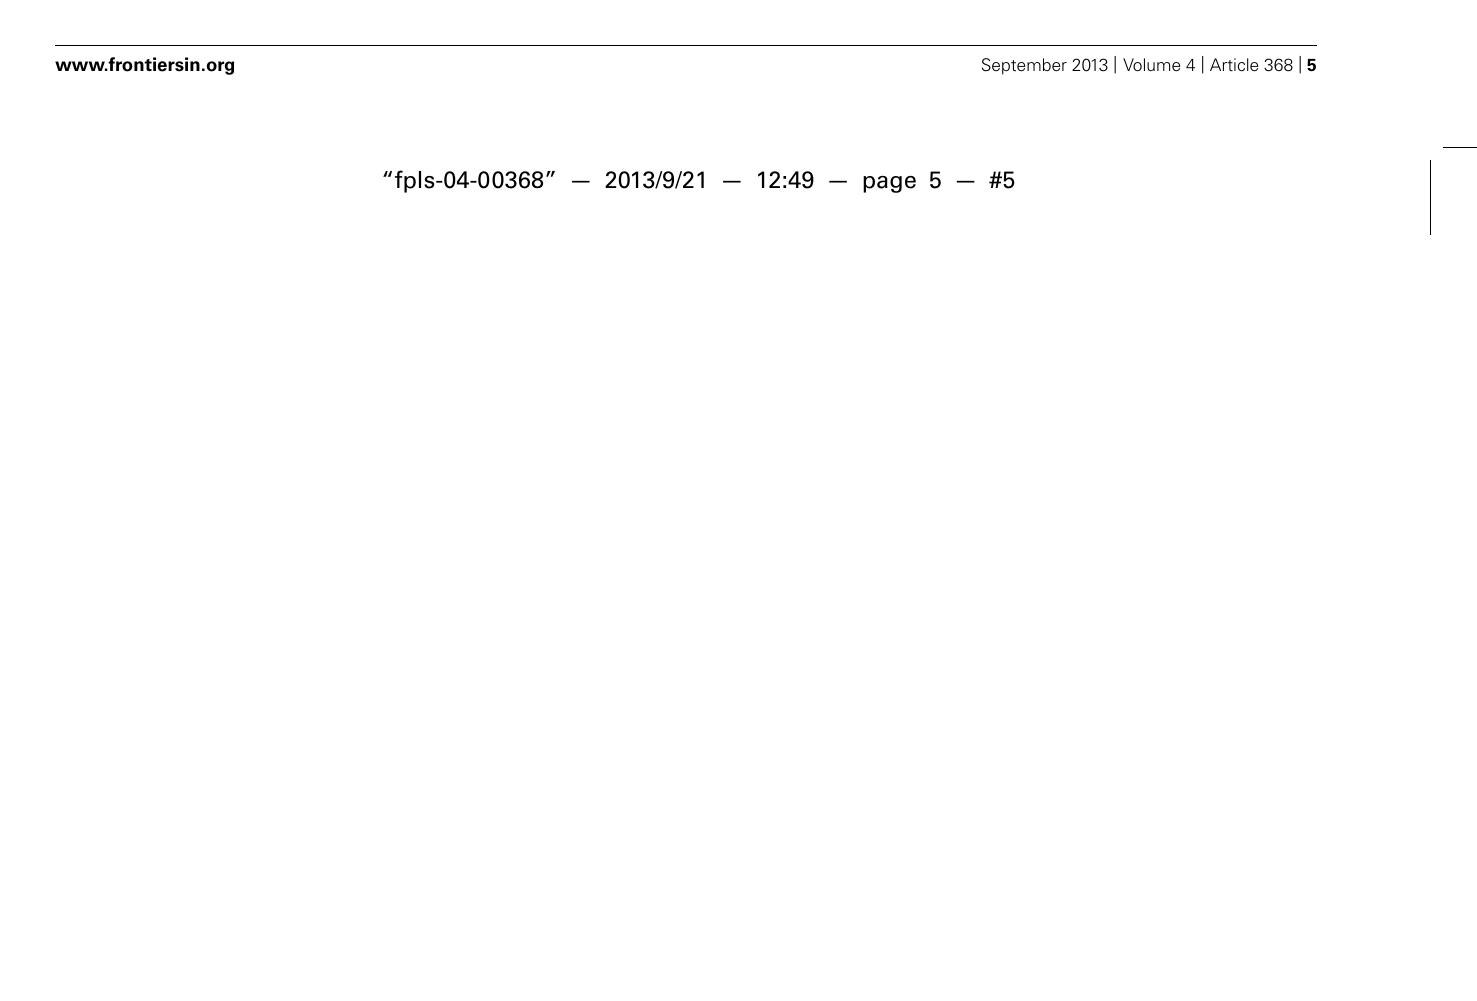
FIGURE 3 | Branch-level sap flux measured on mature A. rubrum trees using heat dissipation sap flow probes . (A) Several consecutive days of measurements are shown after applying 5.5 MPa of (cid:2) P pit (solid lines) compared to non-pressurized control branches (dotted lines). The arrow